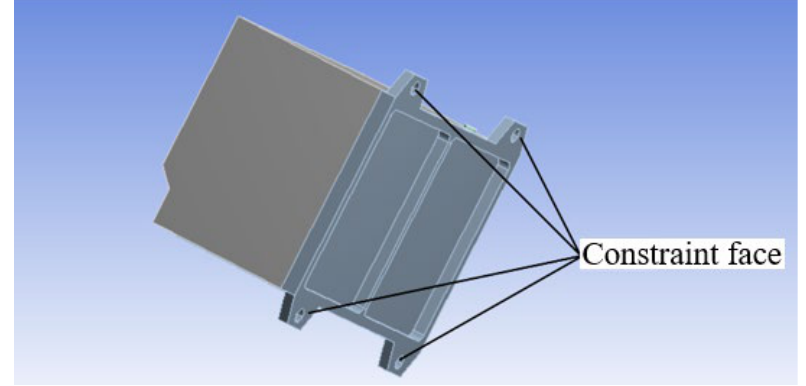
Figure 6. Fixation of electrical control box.